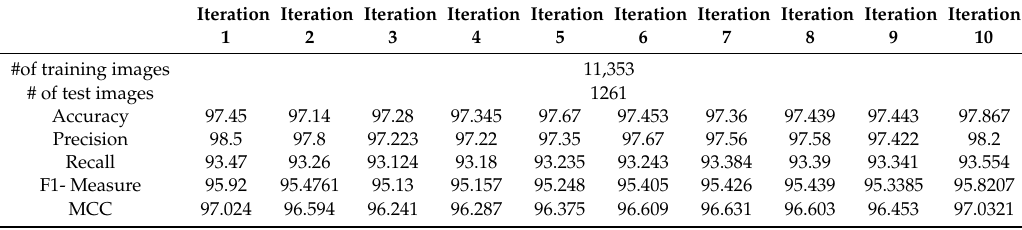
Figure 9. The 10-fold cross-validation average result on CASIA V1.0 using the proposed model. Table 4. The detailed results of 10-fold cross-validation on CASIA V2.0 using the proposed model.